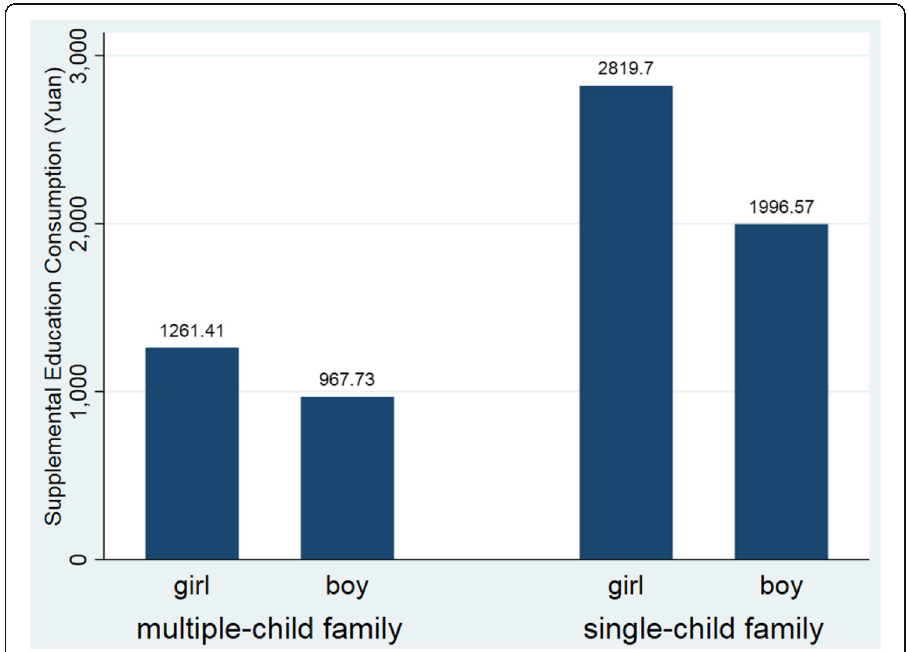
Fig. 2 The structure of children and the expense of supplemental education